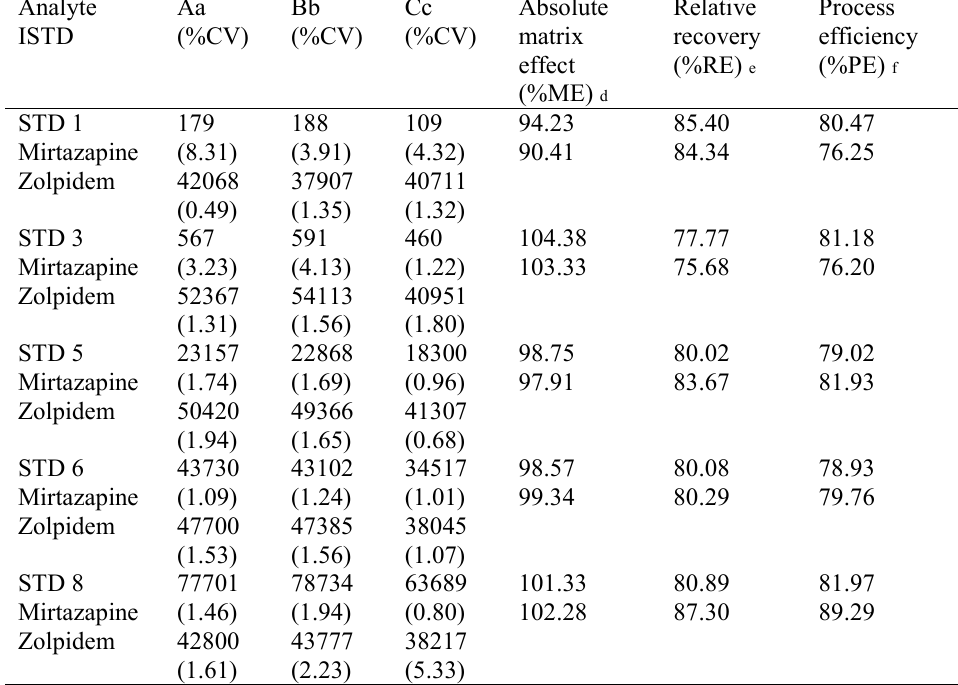
Table 2 . Absolute matrix effect, relative recovery and process efficiency for Mirtazapine.